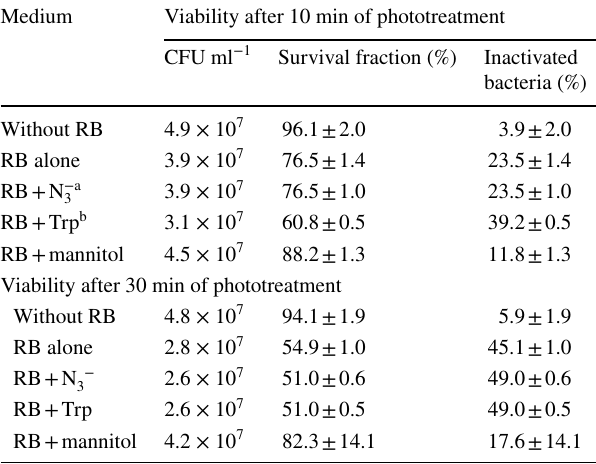
S. aureus Staphylococcus aureus , PBS phosphate buffer solution, RB rose bengal, NaN 3 sodium azide a N 3− anion azide reactive, b Trp